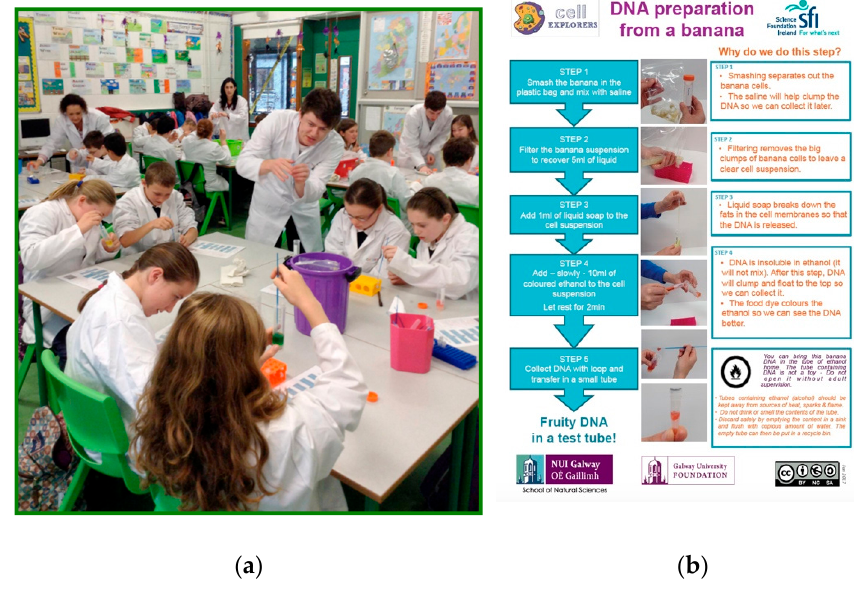
Figure 10. Clockwise: ( a ) Class room experimentation organised by the NUIGalway Cell EXPLORERS Programme; and ( b ) visual protocol as used by Cell EXPLORERS (courtesy of Muriel Grenon and the NUI Galway Cell EXPLORERS Programme).